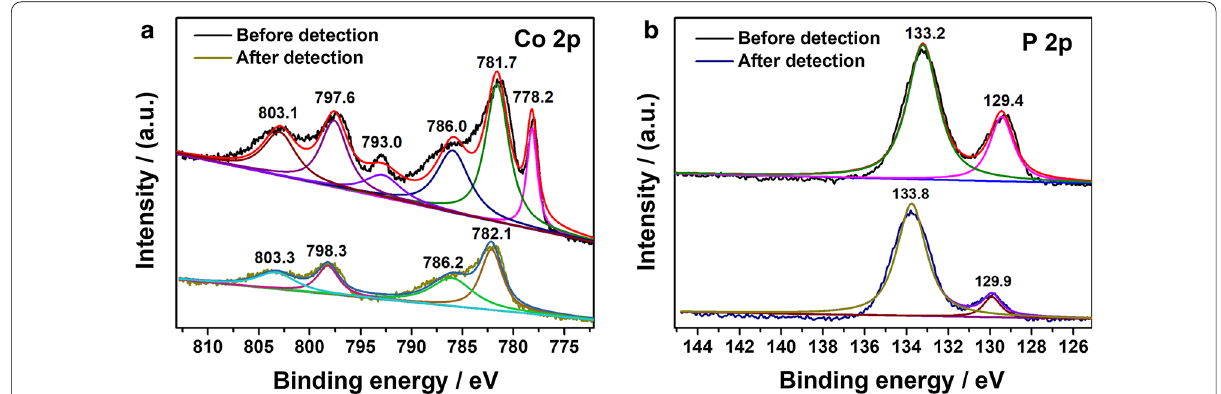
Fig. 3 The comparison of XPS spectra in a Co 2 p region and b P 2 p region of Co 2 P before and after